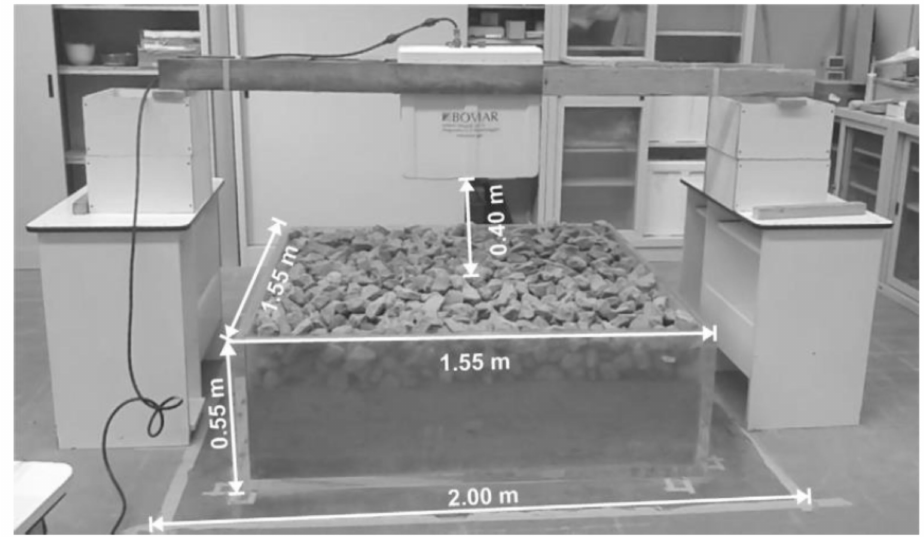
Figure 9. Dielectric constant measurement for ballast samples in ballast box (reproduced from [105]). Artagan et al. [63] in an indoor laboratory built a ballast box filled by ballast